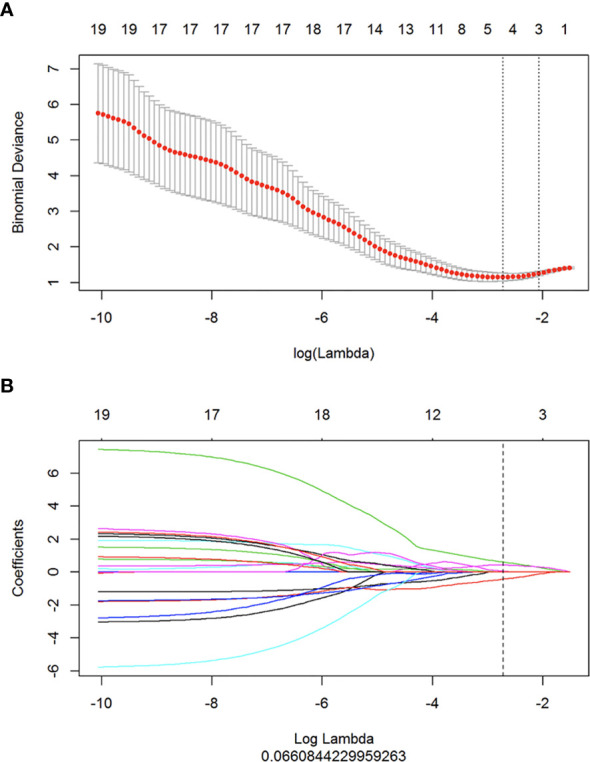
Radiomics feature selection by using mRMR and LASSO. (A) Tuning parameter (λ) selection in the LASSO model used ten-fold cross-validation via minimum criteria. The dotted vertical lines were drawn at the optimal values by using the minimum criteria and 1 standard error of the minimum criteria (the 1 + SE criteria). (B) The LASSO coefficient profiles of the 104 radiomics features. A coefficient profile plot was produced against the log (λ) sequence, and four features were chosen.